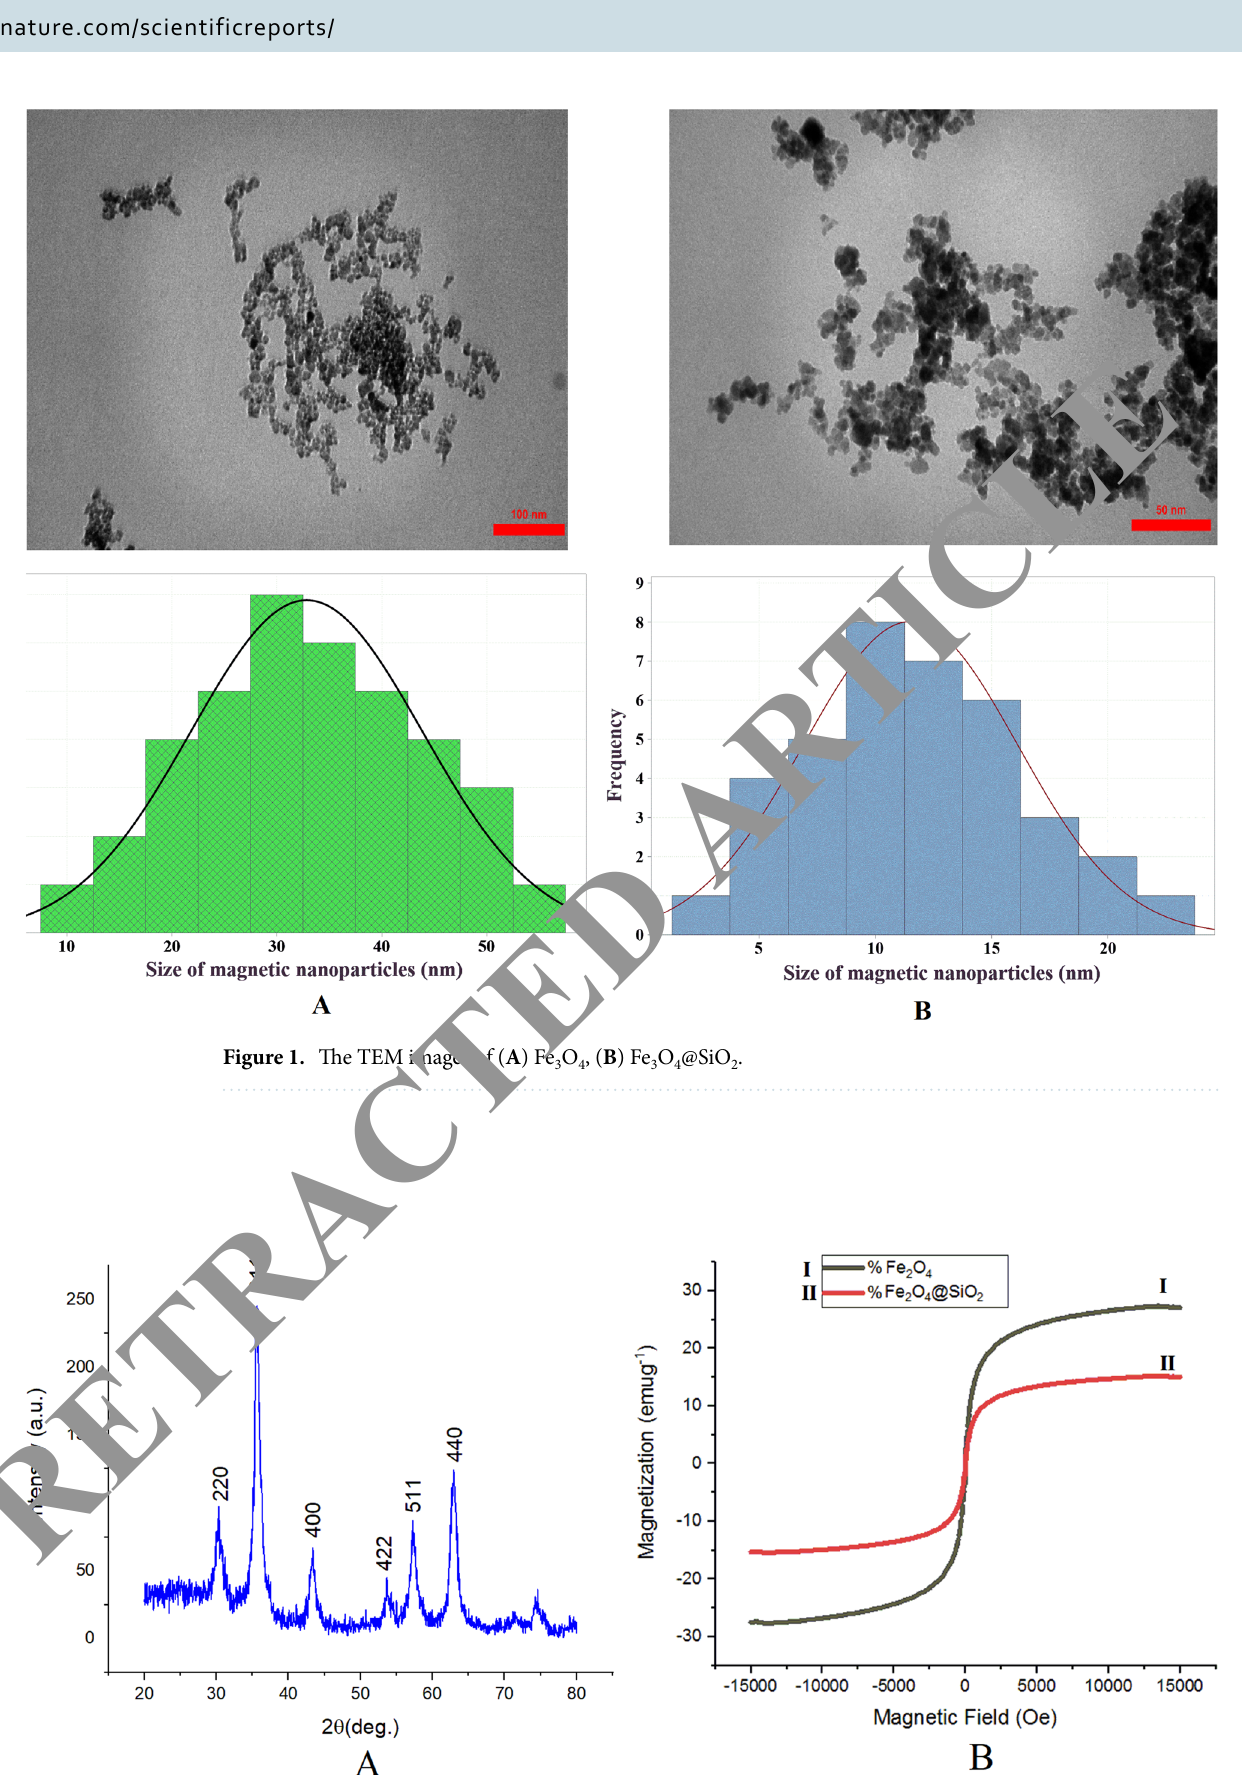
Figure 2. ( A ) The XRD graph. ( B ) The VSM graphs of I: Fe 3 O 4 and II: Fe 3 O 4 @SiO 2